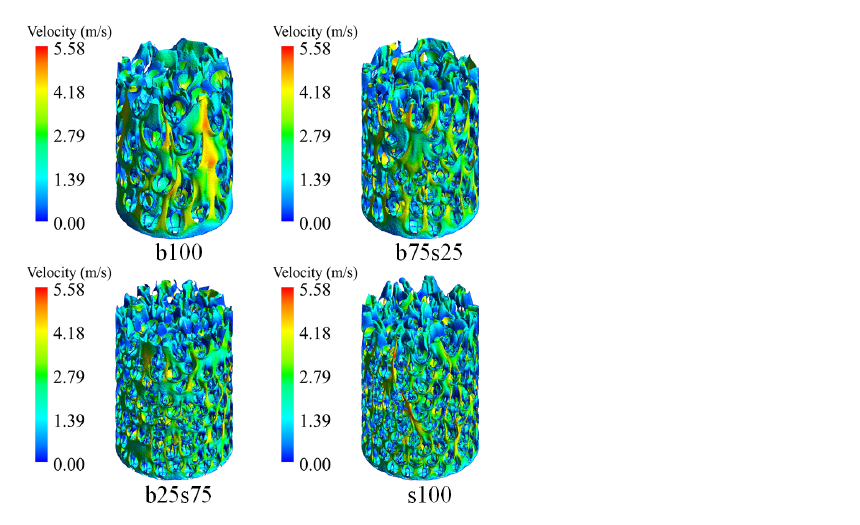
Figure 13. The 3D velocity distributions in different packing structures.